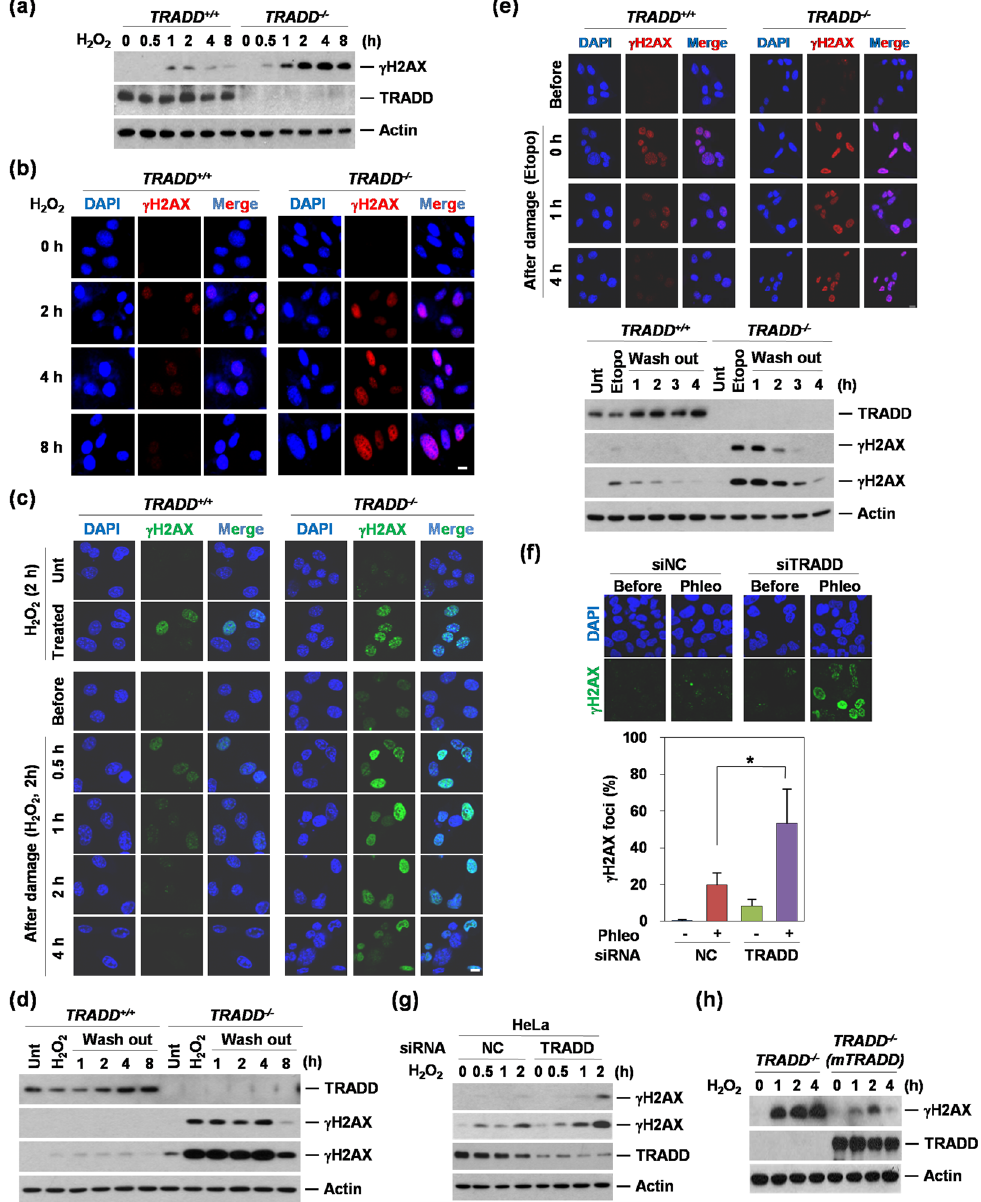
Figure 1. Deficiency of TRADD induces impaired DNA damage response. ( a ) Western blotting analysis shows blotting for γ H2AX, TRADD, and Actin in TRADD + / + and TRADD − / − MEF cells treated with H 2 O 2 in time-dependent manner (0.5 mM). ( b ) γ H2AX foci (Red) were analyzed in TRADD + / + and TRADD − / − MEF cells treated with H 2 O 2 (0.5 mM) by Immunofluorescense as described in A. Scale bars, 10 μ m. ( c ) Immunofluorescence analyses of γ H2AX (Green) in H 2 O 2 (0.5 mM) treated TRADD + / + and TRADD − / − MEF for 2 hours (upper panels) and release from H 2 O 2 treated TRADD + / + and TRADD − / − MEF for 4 hours (lower panels). Cells were stained with anti- γ H2AX (Green) and DAPI (Blue). Scale bars, 10 μ m. ( d ) Western blotting analysis shows results consistent with immunofluorescence as described in ( c ). ( e ) After cells were treated with etoposide (25 μ M) for 1 hour, TRADD + / + and TRADD − / − MEF replaced with fresh media. Cells were stained with anti- γ H2AX (Red) and DAPI (Blue). Western blotting analysis (lower panel) shows the consistent results with immunofluorescence. Scale bars, 10 μ m. ( f ) Quantitative analysis of γ H2AX foci was conducted in TRADD knock-downed U2OS cells. After TRADD knockdown, cells were treated with phleomycin (Phleo) and then stained with γ H2AX antibody. * P < 0.05 (Student’ s t-test). ( g ) Transient knockdown of TRADD induces unrepaired DNA damage in HeLa cells. Western blot analysis shows γ H2AX status in response to H 2 O 2 in TRADD KD HeLa cells. Cells were transfected with siRNA TRADD or siRNA negative control (NC), respectively. After 48 hours, the cells were continuously treated with H 2 O 2 (0.5 mM). The whole cell lysates were analysed by western blot as using indicated antibodies. ( h ) Reconstitution of TRADD in TRADD − / − MEFs. Western blotting analysis shows γ H2AX expression in response to continuous treatment with H 2 O 2 (0.5 mM) in different time